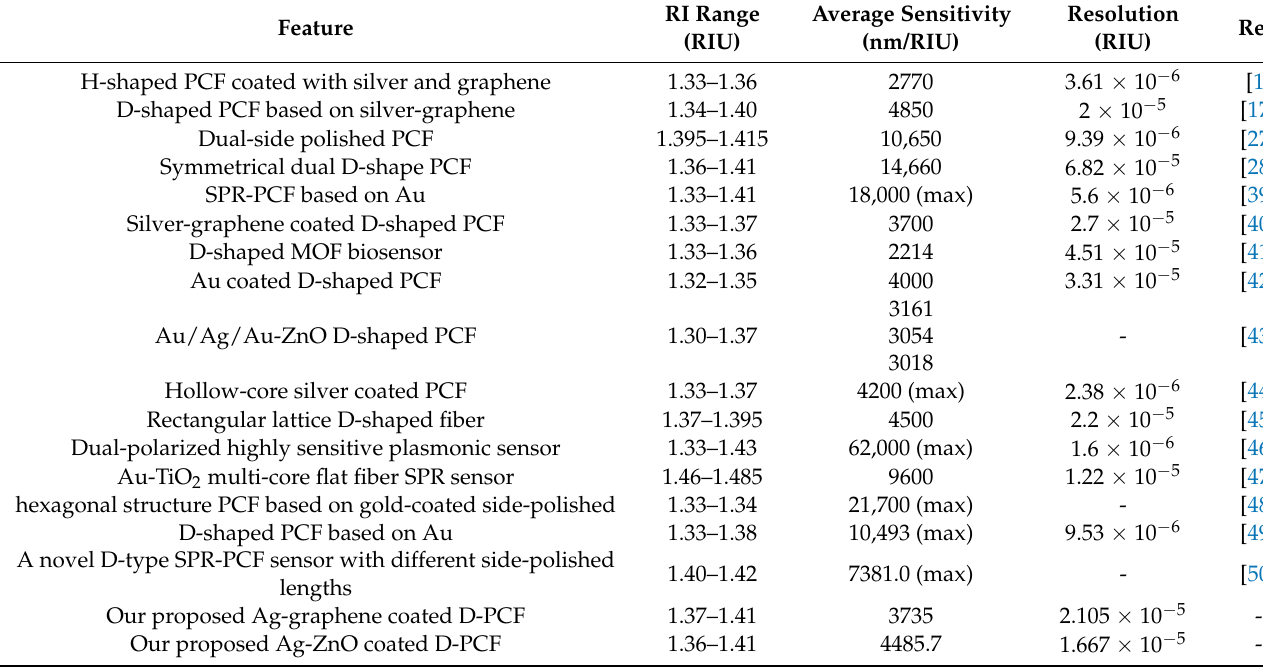
Table 3. Performance comparison of fiber optic sensors based on